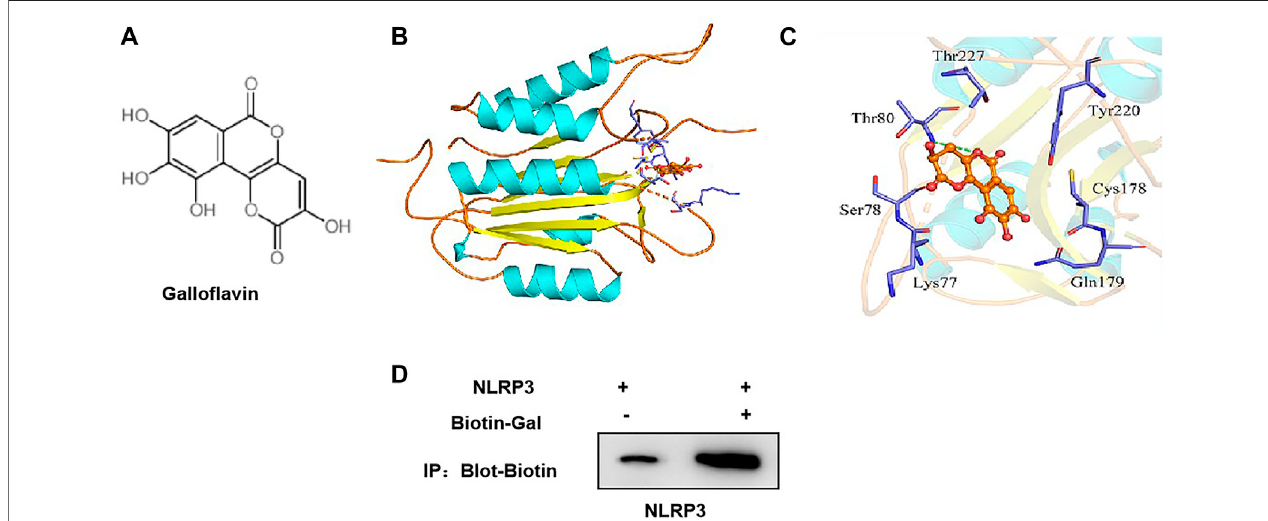
FIGURE 6 | Targeted-binding relationship between gallo fl avin and NLRP3. (A) : Schematic diagram of the molecular structure of gallo fl avin (B,C) : Molecular docking model of gallo fl avin and NLRP3. (D) : Pull-down assay between Biotin – Gal and NLRP3 showed that Gal had a targeted-binding relationship with NLRP3.